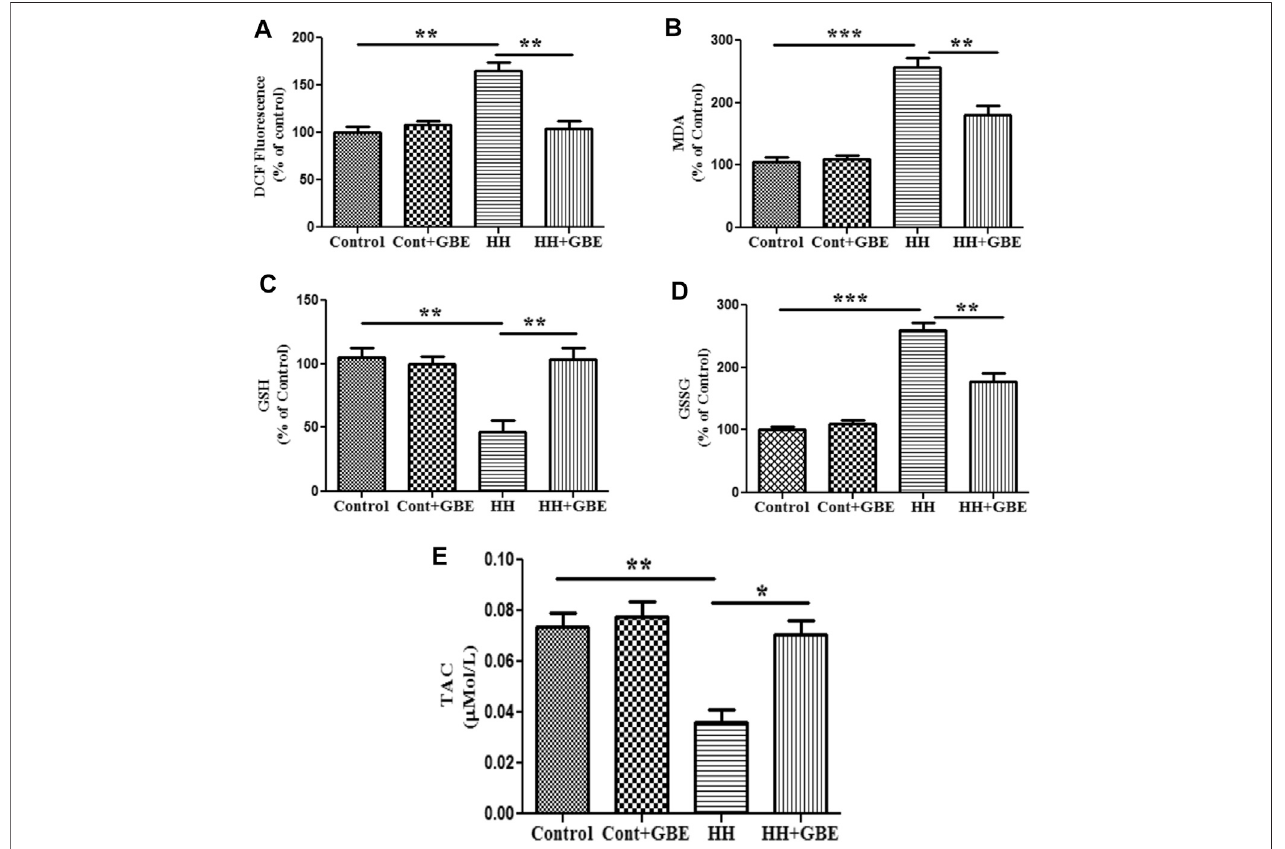
FIGURE 3 | GBE prevents HH-induced oxidative damage. Representative bar graphs of oxidative stress markers such as ROS level (A) , lipid peroxidation (MDA) (B) , GSH (C) , GSSG (D) , and TAC (E) . 14 days of HH exposure increased the level of ROS and MDA; however, GBE signi fi cantly decreased their elevation. GSH was decreased after 14 days of HH exposure, and GBE treatment signi fi cantly reverted these effects. HH increased the level of GSSG, which was further reduced by GBE treatment. Furthermore, TAC was increased signi fi cantly ( p < 0.05) after GBE treatment as compared to the HH group. One-way ANOVA with the Bonferroni test was used to analyze the data. The results are expressed as mean ± SEM. * p < 0.05, ** p < 0.01, and *** p < 0.001.